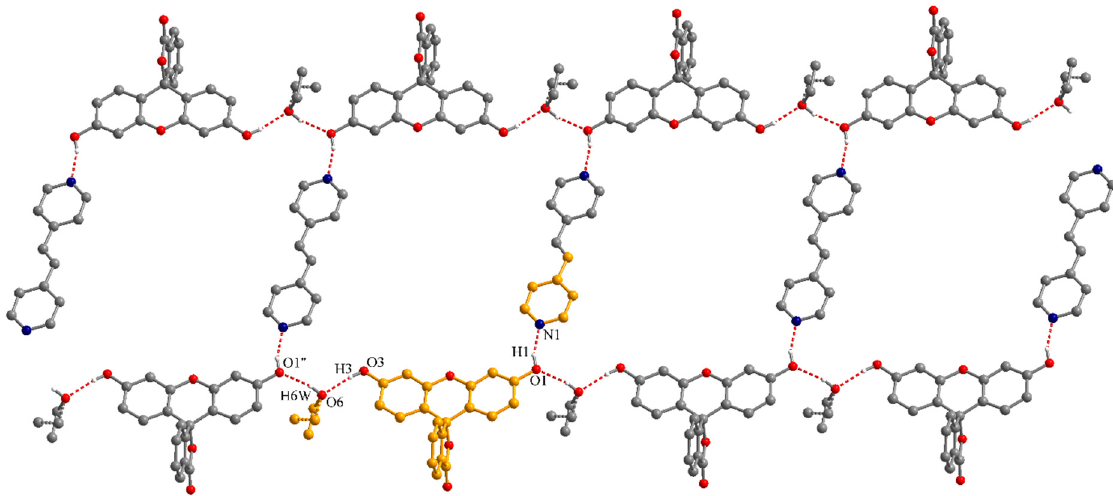
Figure 7. Perspective view of the 1D supramolecular array formed through hydrogen interactions in crystal 3 (the hydrogen atoms not involved in hydrogen interactions were omitted for clarity). Symmetry code: “= − 1 + x, y, − 1 + z.